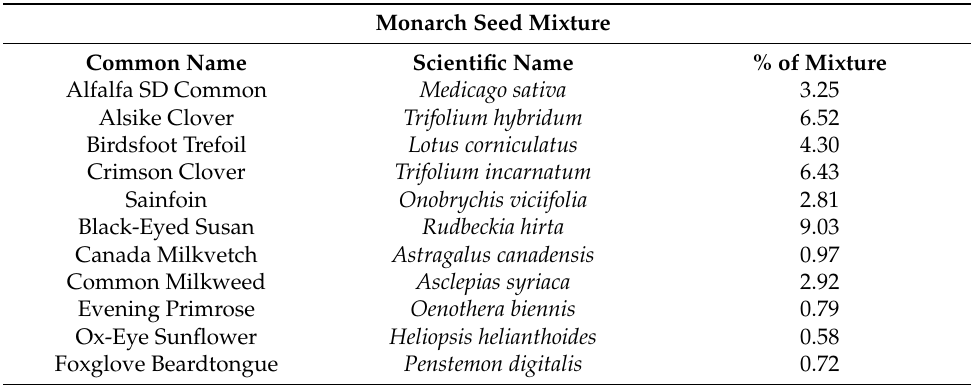
Table A1. Seed mixtures used to establish floral